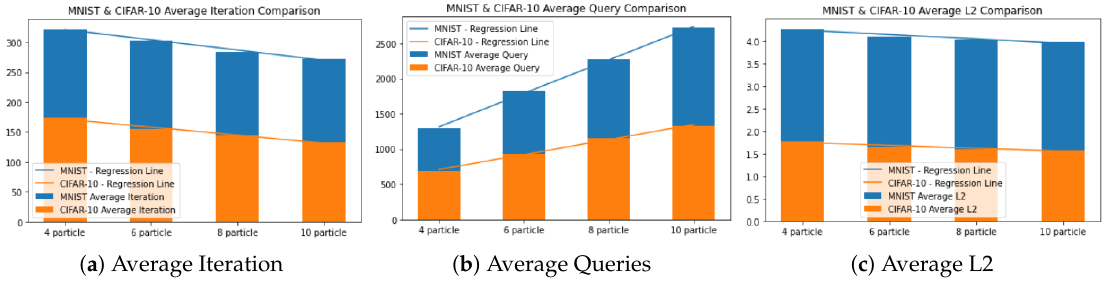
Figure 5. Particle size evaluation. X -axis for all graphs represents the particle size (from 4 to 10). Y -axis for ( a ) is average iteration. Y -axis for ( b ) is average queries. Y -axis for ( c ) is average L 2